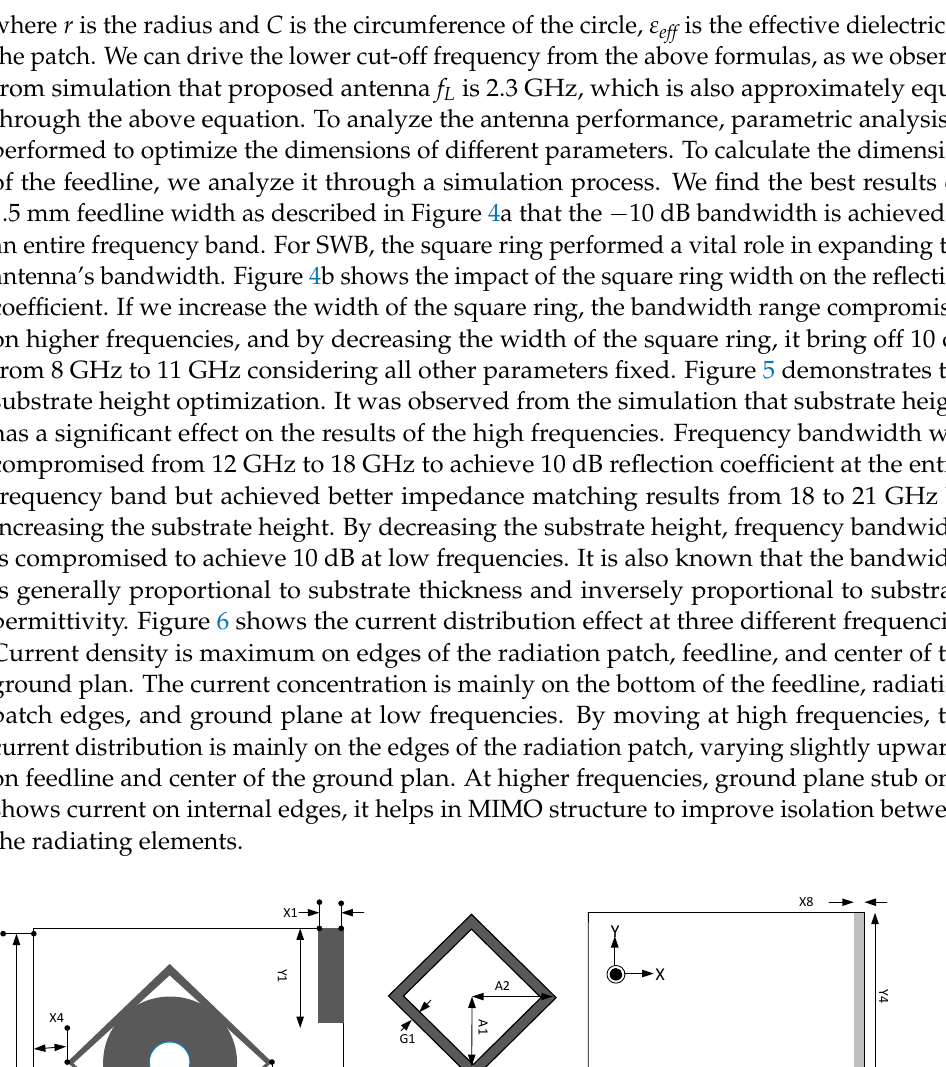
( c ) Figure 2. Antenna investigation analysis ( a ) Type I, ( b ) Type II, and ( c ) Type III.